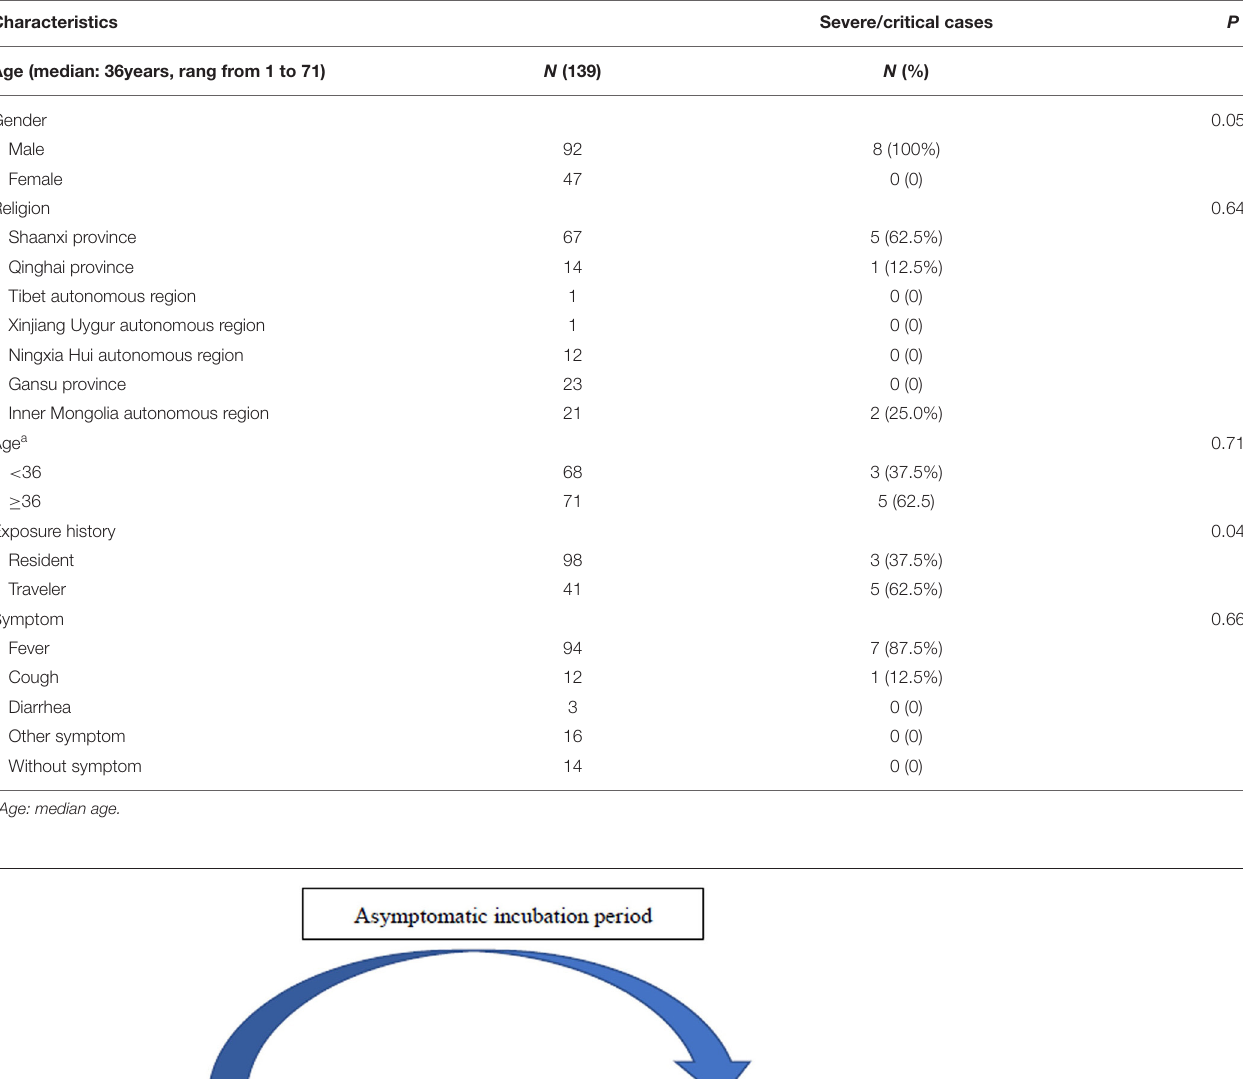
severity status of COVID-19 and clinical characters was analyzed by using a χ 2 -test. Normal distribution and homogeneity of variances were tested, T -test and variance analysis were performed to compare the difference among the variables,